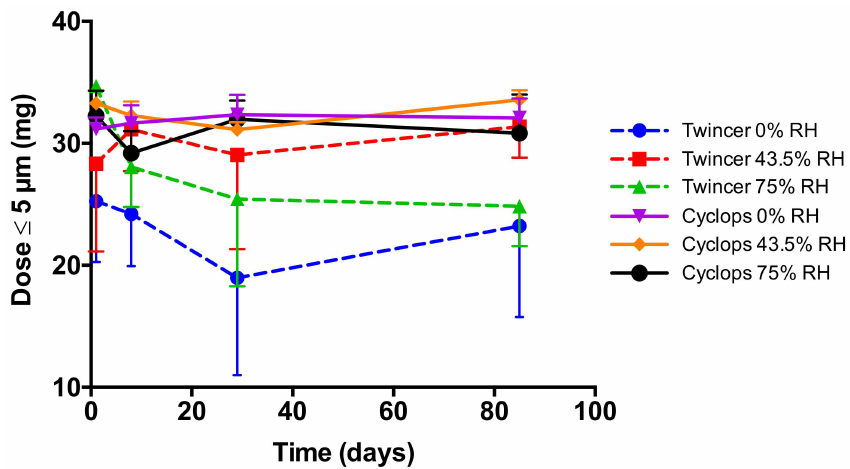
Figure 8. The fine particle dose delivered from the Twincer ® and Cyclops ® DPIs over a three-month storage period. Tests were performed with a 50 mg nominal dose of the 3% trileucine formulation spray-dried at 40 ◦ C ( n = 4, average ± SD). Powders were stored in open containers at 0, 43.5, and 75% RH.